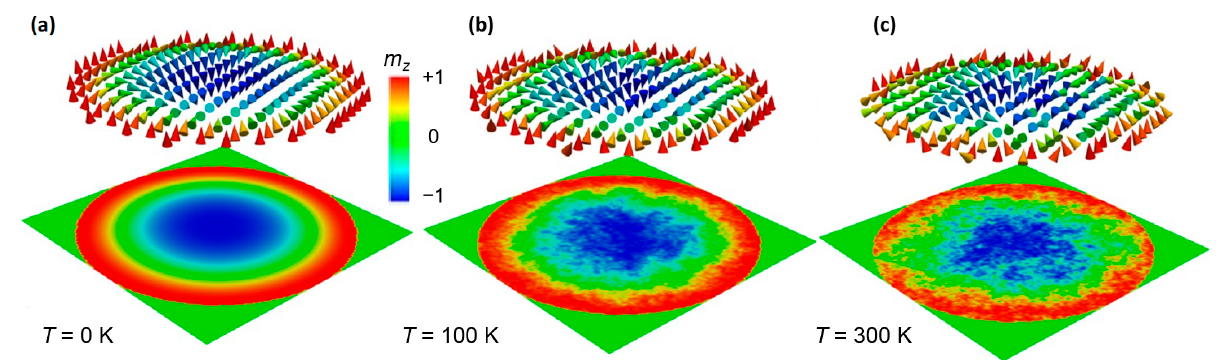
32 of 35 Figure A1. ( a ) DMI - PMA - Q phase diagrams calculated at different temperatures 0 K, 100 K, 300 K. ( b ) Magnetization vector field representation of skyrmionic structures corresponding to the point ( DMI = 5 mJ/m 2 , K u = 1.7 × 10 +6 J/m 3 ) indicated with a white filled circle in the diagrams of the panel ( a ). The calculation has been performed for a 90 nm disk with the following fixed parameters: M s = 1714 kA/m, A ex = 2.1 × 10 +11 J/m; the Gilbert damping constant α = 0.01. At a finite temperature, locally, the spin orientation will have a random distribution around the “equilibrium” zero-Kelvin position. The larger the temperature, the larger the width of this distribution. The temperature and DMI dependent random distribution of local spins orientation will further affect the value of the numerically calculated topolog-